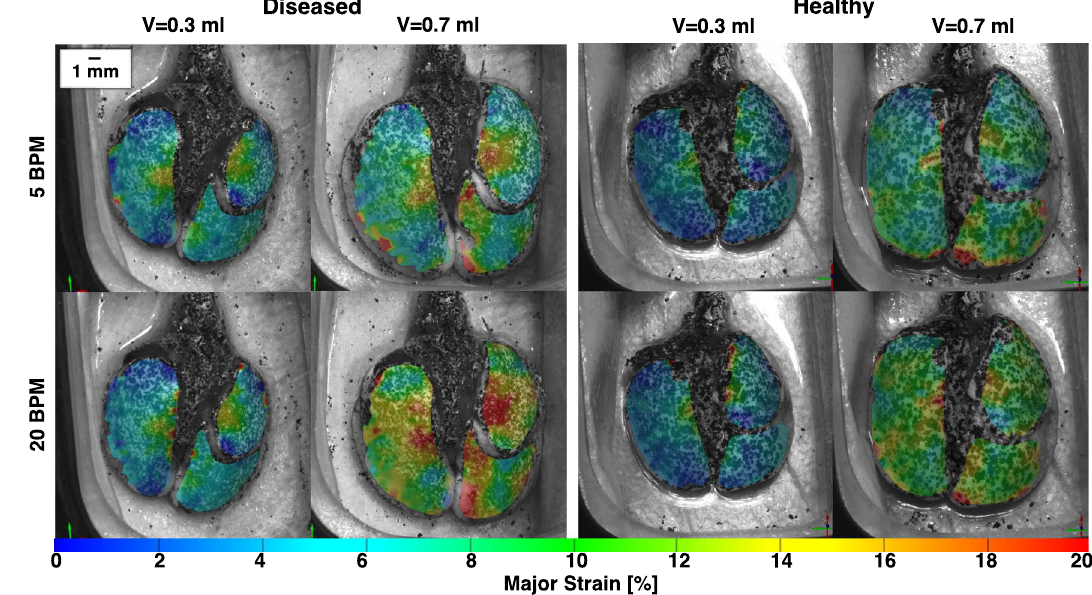
Figure 2. Representative murine diseased and healthy lungs topological major strain contours, shown at peak inflation for the smallest and largest applied volumes (0.3 and 0.7 ml) and the two inflation frequencies (5 and 20 BPM), illustrated qualitative strain variations between volumes, inflation rates, and health state.